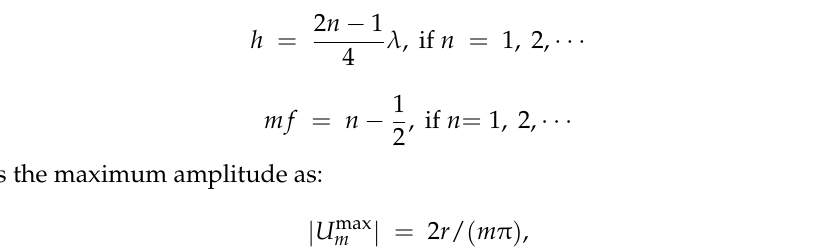
From Equation (13), the value sin( mf i π ) may be positive or negative. These two cases will be analyzed to investigate the influence of the sign of the sin( mf i π ) value on the groove width g i . When the signs of the sin( mf i π ) and sin( mf i +1 π ) values are the same, to make directions of U ( m , i ) and U ( m , i +1) consistent, ∆ θ i must be: m